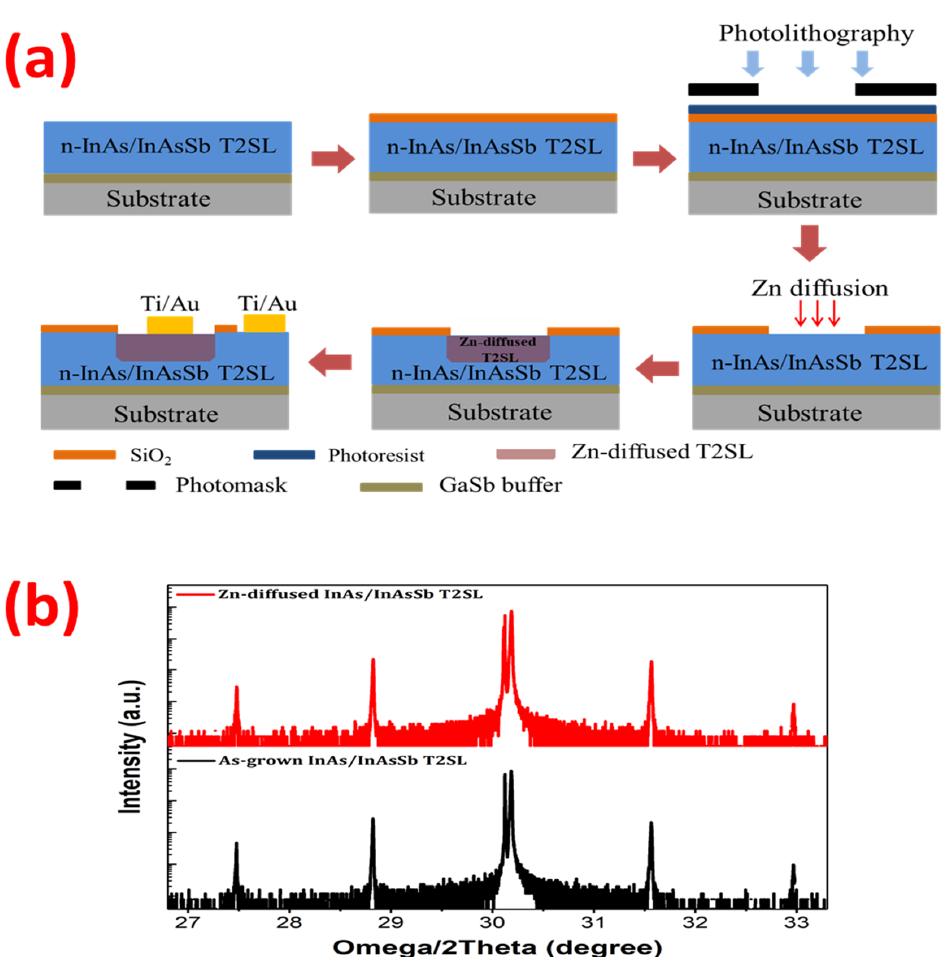
Figure 1. ( a ) Schematic diagram of fabrication processes for the Zn-diffused planar photodetector based on InAs/InAsSb T2SL. ( b ) HR-XRD scan curve of the as-grown (black) and Zn-diffused (red) InAs/InAsSb T2SL on GaSb substrate.